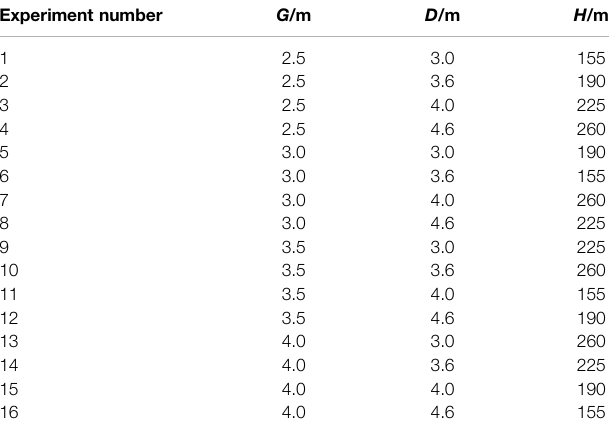
TABLE 4 | Orthogonal experiment table for researching k 2 L16(4 3